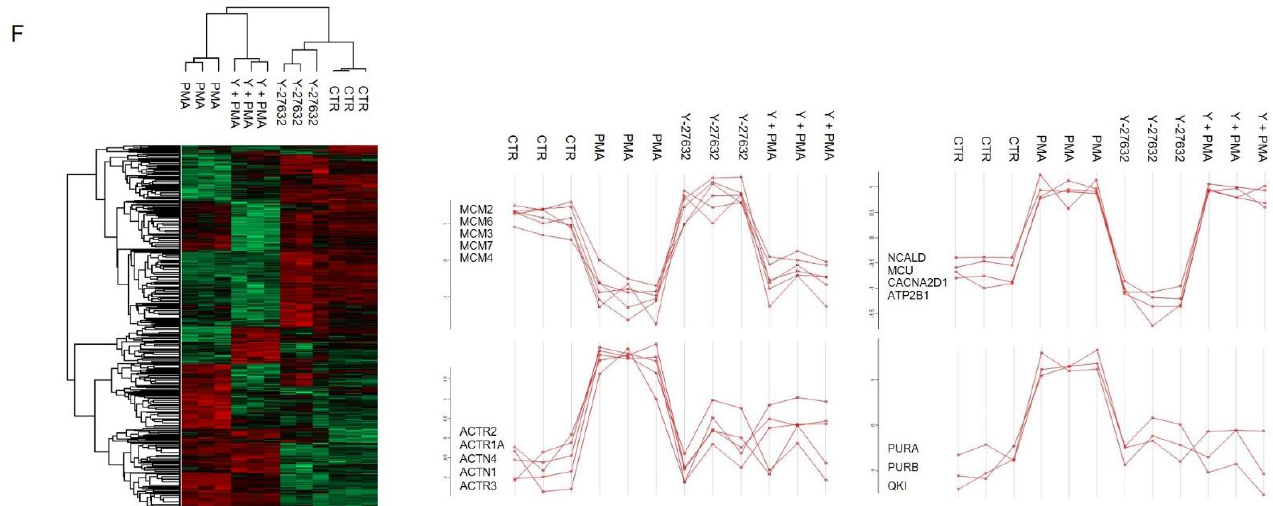
Figure 4. Signaling pathways and transcriptional factors modulated by PKC activation. ( A ) “Regulation of actin cytoskele- ton” KEGG pathway is visualized. Red stars indicated differentially expressed proteins involved in the pathway and identified by MS/MS analysis, or Western blotting, after PMA treatment. ( B ) Expression profile of cofilin and phospho- cofilin was detected by Western blot at 0 h, 24 h, 48 h, 72 h and 96 h after treatment with PMA. Histogram represents the expression ratio of phospho-cofilin of the treated condition versus CTR sample. *** p -value < 0.001. ( C ) Phase-contrast image s of MO3.13 cells cultured in a normal condition medium or treated with 100 nM PMA and 10 μM Y -27632, alone or in combination, for 96 h. Scale bar 200 μm. ( D ) Western blot analysis showing the activation level of PKC substrates in control and treated conditions after 1 h of stimulation. PMA at 100 nM and Y- 27632 at 10 μM were used alone or in com- bination. The detection was performed through a phospho-PKC substrate motif ((R/K)XpSX(R/K)) antibody. The Ponceau S stained membrane is shown to verify the protein loading. ( E ) Western blot analysis showing the expression levels of cofilin and phospho-cofilin after treatment with PMA and Y-27632, used alone or in combination, for 96 h. Histogram represents the expression ratio of phospho-cofilin in the treated conditions versus the CTR sample. *** p -value < 0.001. ( F ) Hierarchical clustering based on Euclidean distance showing the separation between the CTR cells and those treated with PMA and Y-27632, alone and in combination. Profile plots of selected protein groups are shown, displaying distinct be- havior concerning treatment.